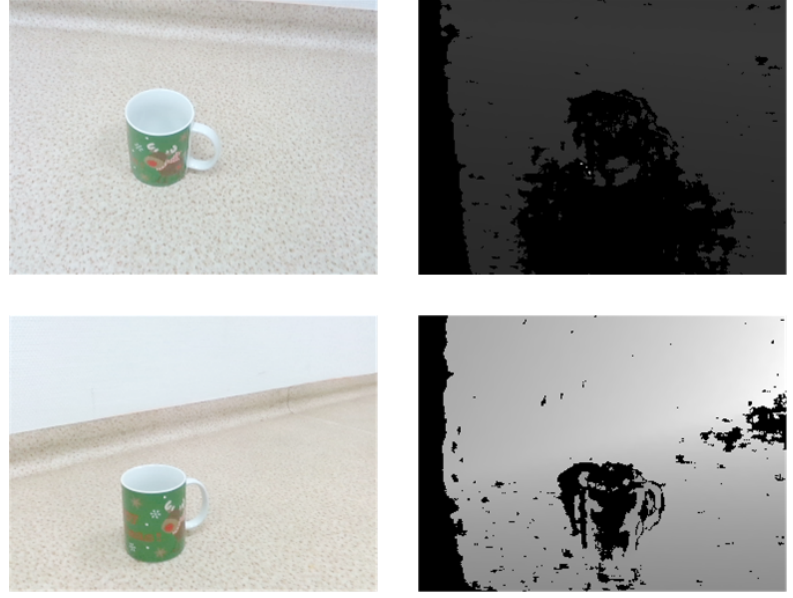
Figure 14. An example of corrupted